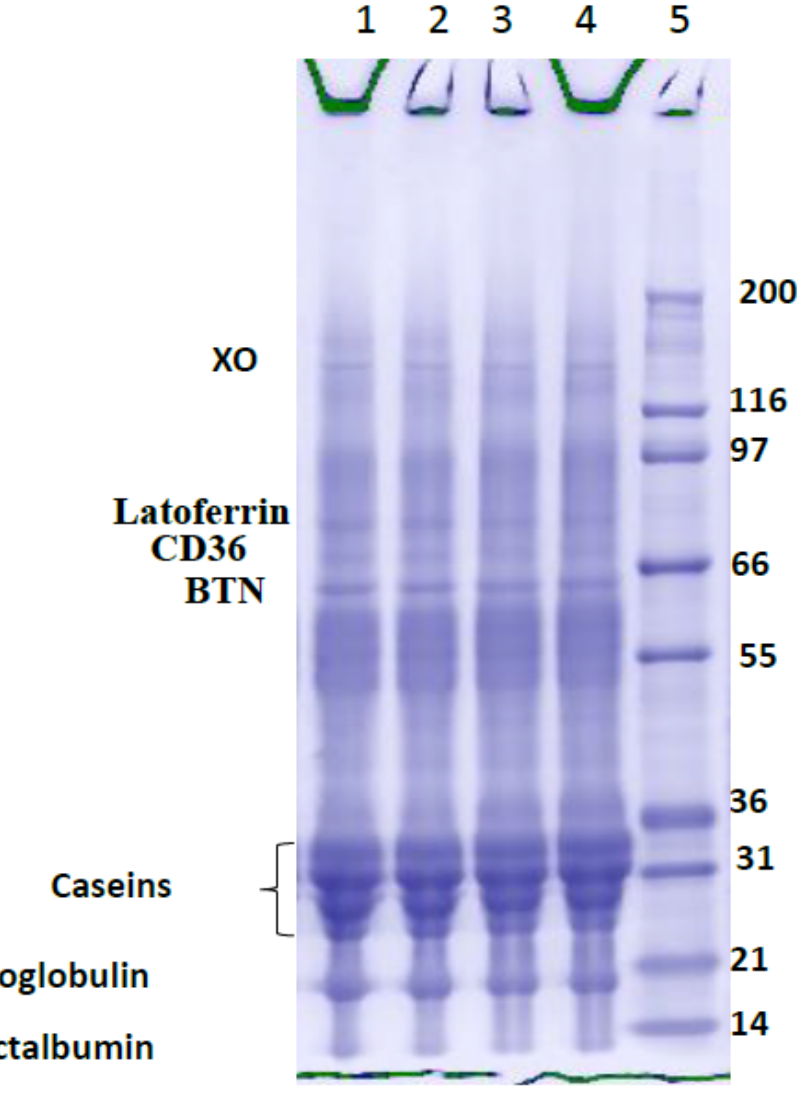
Figure 2. SDS-PAGE elucidates the MFGM-specific protein profile of set yogurts prepared from different milk materials with a 4% enriched MFGM fragment under two-stage pressure homogenization. Line 1: Non-homogenized raw milk (NRM), Line 2: Homogenized raw milk (HRM), Line 3: Homogenized processed milk (HPM), Line 4: Non-homogenized processed milk (NPM), Line 5: SDS-PAGE molecular weight standard. Table 1. Composition of set yogurts produced from raw milk or processed milk combined with Lacprodan ® PL20 on a dry- matter basis expressed as (g/100 g).